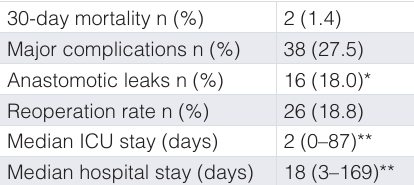
Table 3. Outcome of surgery (* % of patients with at least one anastomosis ** Data represent median and range).